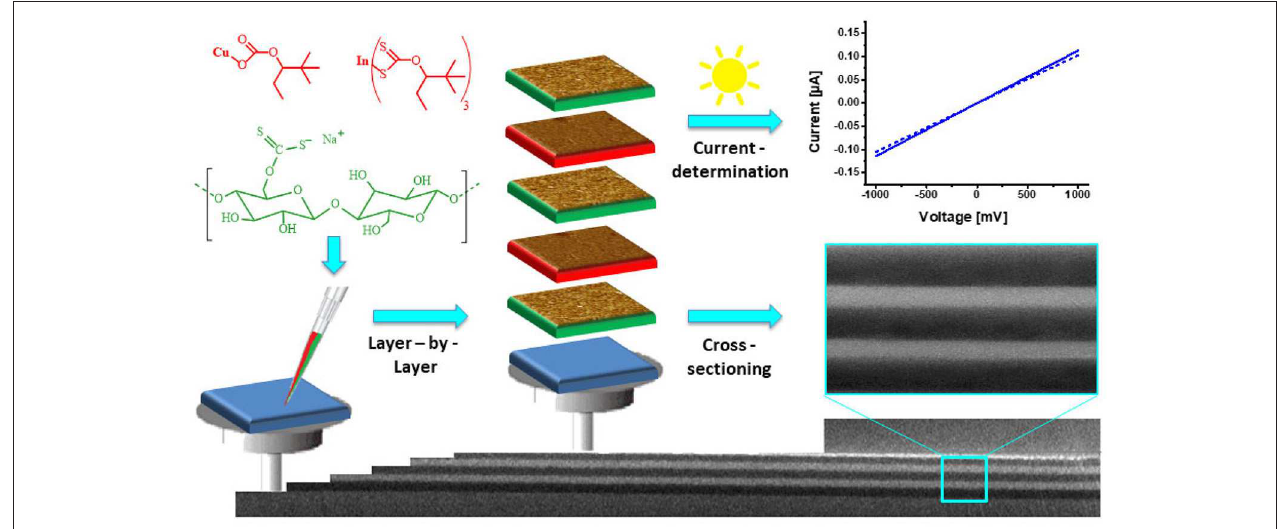
FIGURE 12 | Schematic illustration of the preparation of cellulose/CuInS 2 multilayer films and their characterization using cross-sectional SEM (Reproduced from Weißl et al., 2019 with permission from